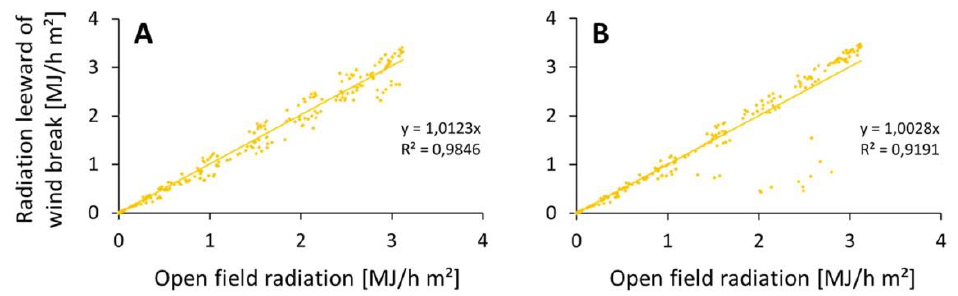
Figure 5. Radiation of open field conditions (Rs open field ) versus radiation (Rs wind break ) leeward of the single row tree wind break at the following distances from the tree wind break: 21.25 * H (in subgraph A ) and 26.8 * H (in subgraph B ). Distances are expressed in multiples of the wind break tree height (H).